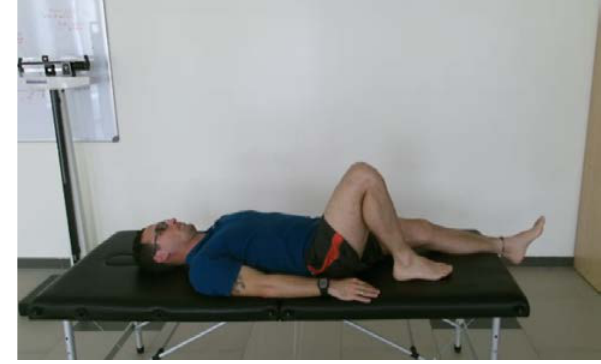
Figure 4 | Screenshot of an exercise demonstration video.